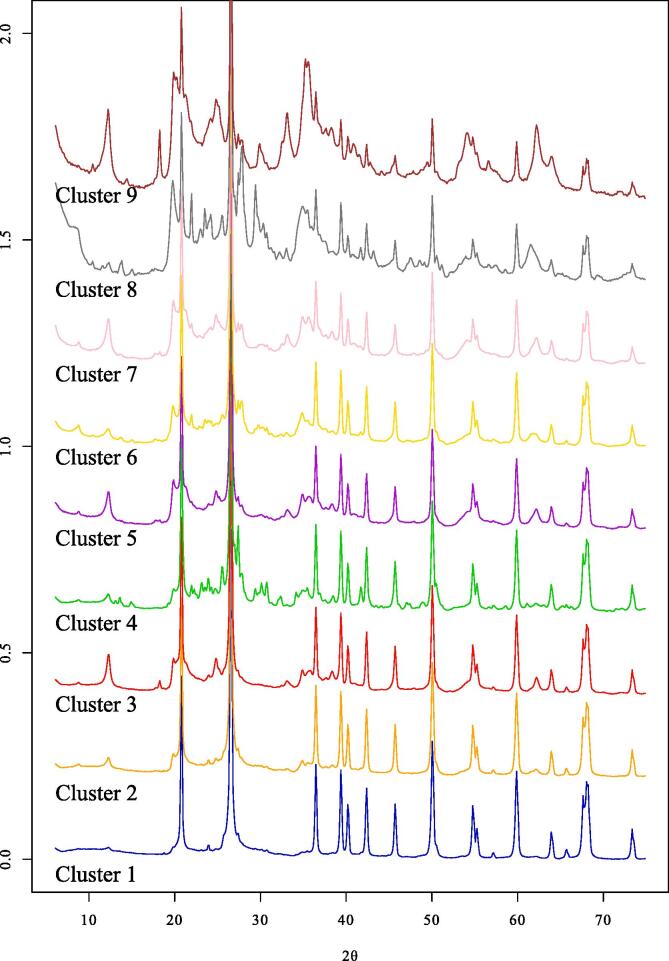
The mean diffractograms for each cluster, which were subsequently used to derive quantitative estimates of each cluster’s mineralogy. The y-axis has been square-root transformed to aid with comparison.